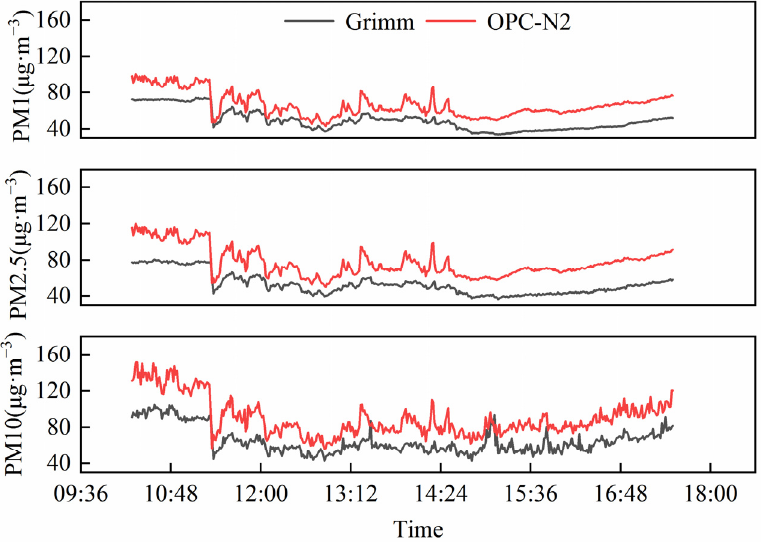
Figure 4. Comparison measurement results of OPC-N2 and Grimm for ambient air PM concentrations in outdoor monitoring.